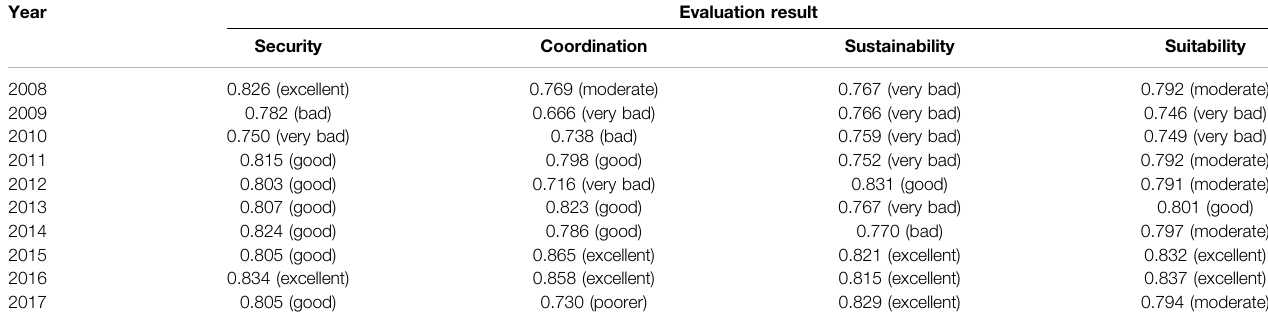
TABLE 6 | Evaluation results of security, coordination, sustainability, and